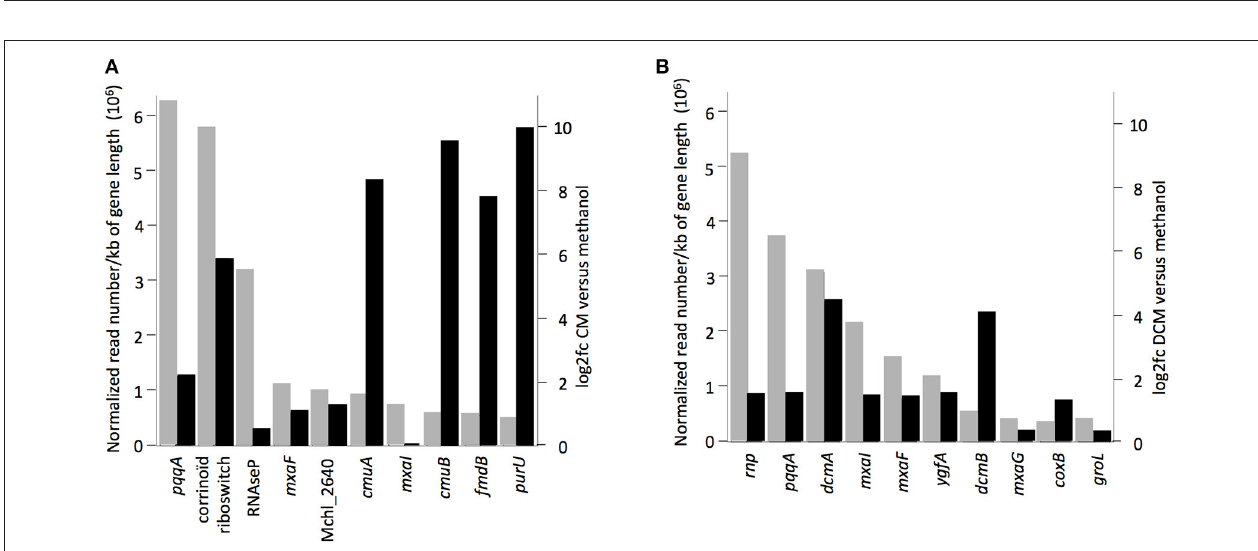
FIGURE 3 | Genes with highest transcript abundance in cultures grown with chlorinated methanes compared to with methanol. Black rectangles indicate values of log 2 fc (values higher than 2.0 or lower than − 2.0 mean normalized reads more abundant in cultures grown with chlorinated methanes or with methanol, respectively). Gray rectangles represent normalized read numbers divided by gene length in kb. RNA-Seq data from cultures of (A) M. extorquens CM4, (B) M. extorquens DM4.